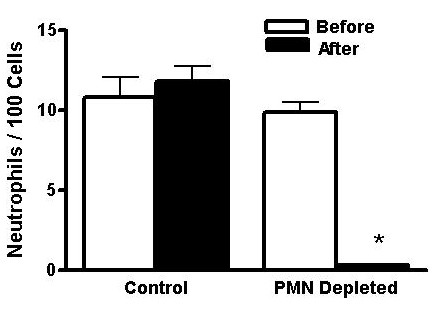
Neutrophil counts at baseline and at 24 hours after normal rabbit serum (control) or anti-PMN antibody (PMN-depleted) administration. Anti-PMN antibody resulted in a consistent decrease in circulating neutrophils to less than 10% of baseline counts whereas there was no change in neutrophil counts in control animals that received the normal rabbit serum. *p < 0.001 control (n = 8) vs after PMN-depletion (n = 10).